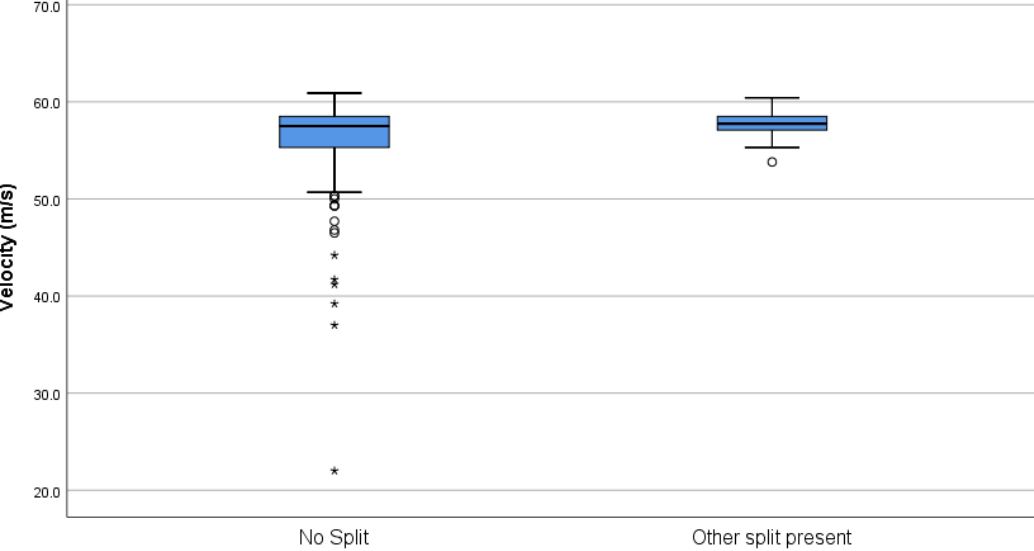
Table 1. Mean, SD and the results of the Levine’s test and t -test comparing the cartridge weight components between the two brands of